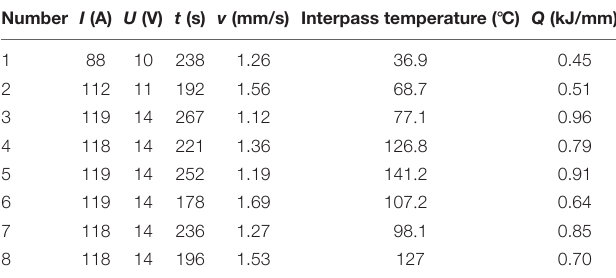
TABLE 2 | The relationship between heat input and interpass temperature of each